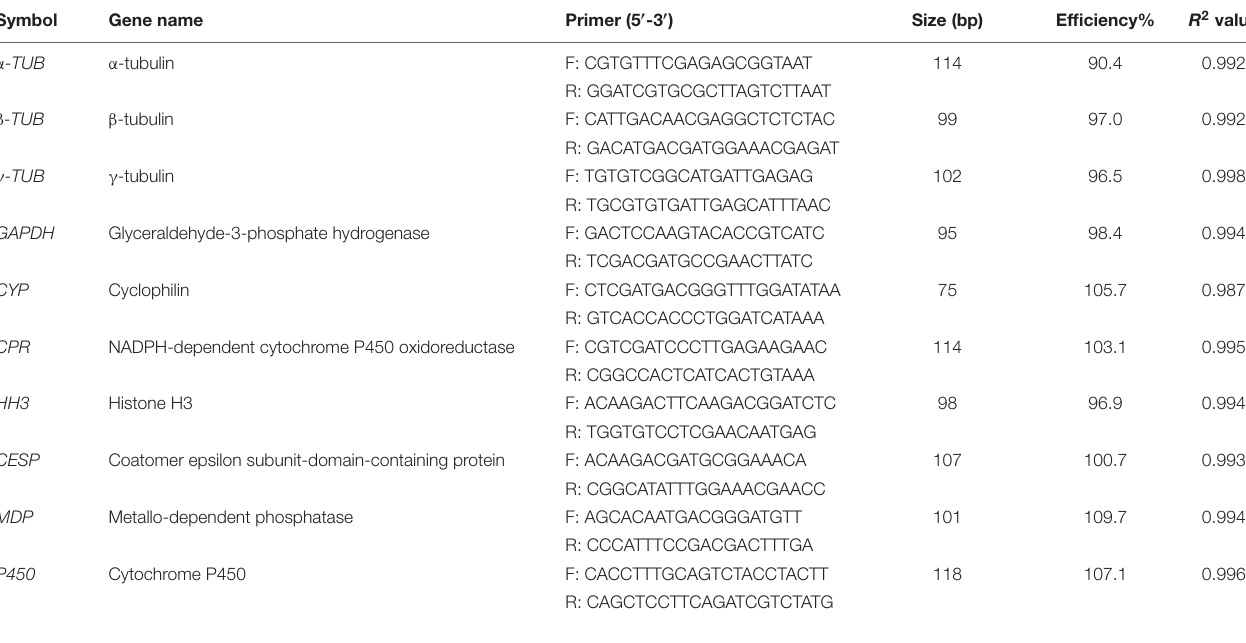
TABLE 1 | Primer sequences and amplification characteristics of the candidate reference